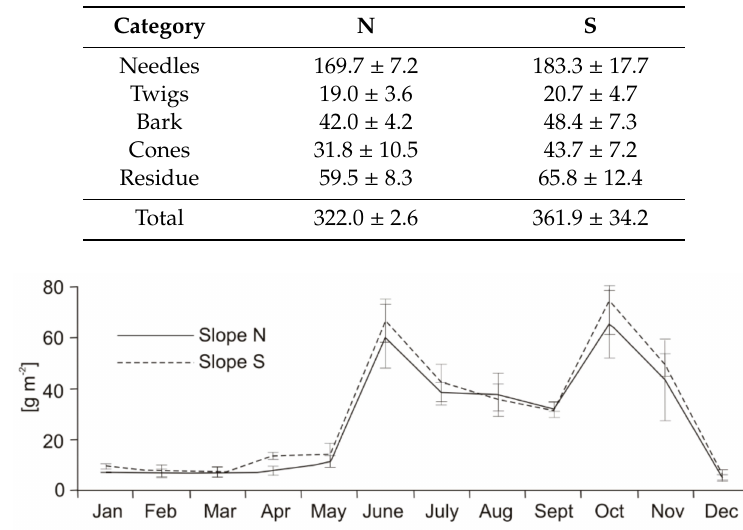
Table 1. Mean mass ( ± SE) of the total annual litterfall and mass of the studied categories of litterfall (g m − 2 year − 1 ) on slopes N and S (averaged for the three study years).